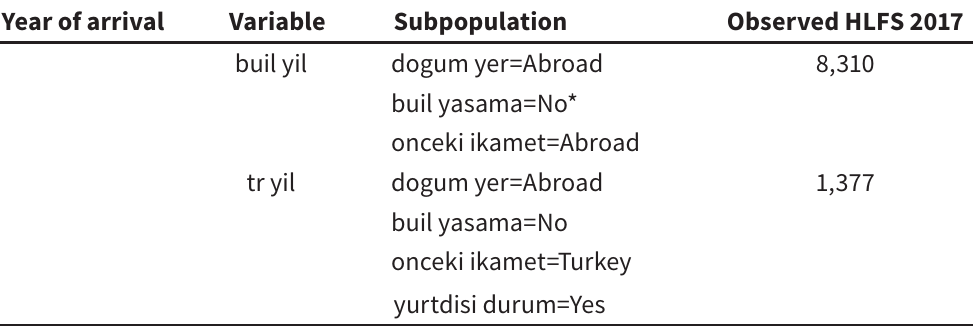
Construction of the variable ‘year of arrival to Turkey’.